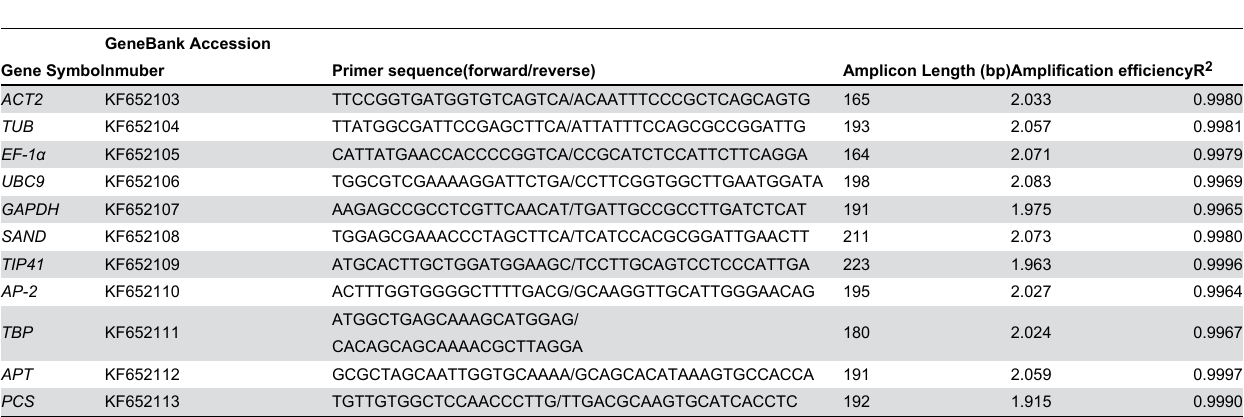
Table 1. Candidate reference genes, primers and different parameters derived from RT-qPCR analysis.